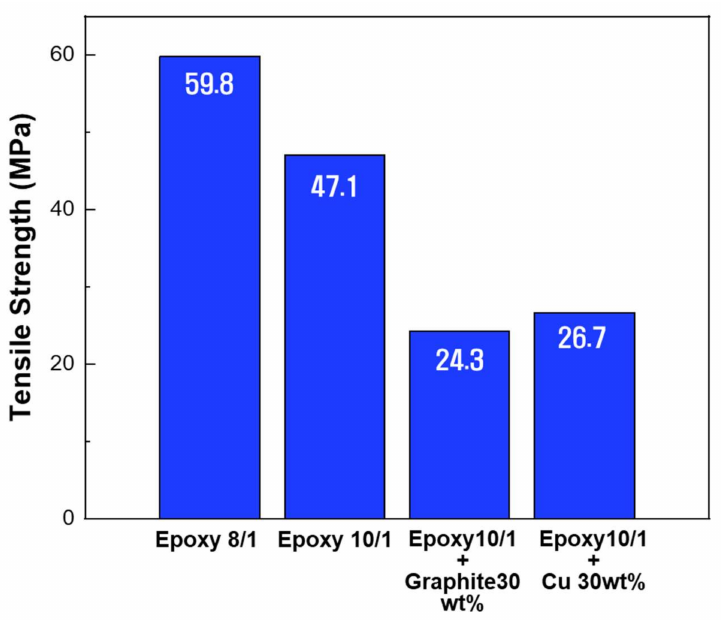
Figure 7. Results of Tensile strength for three ratios of epoxy resin to